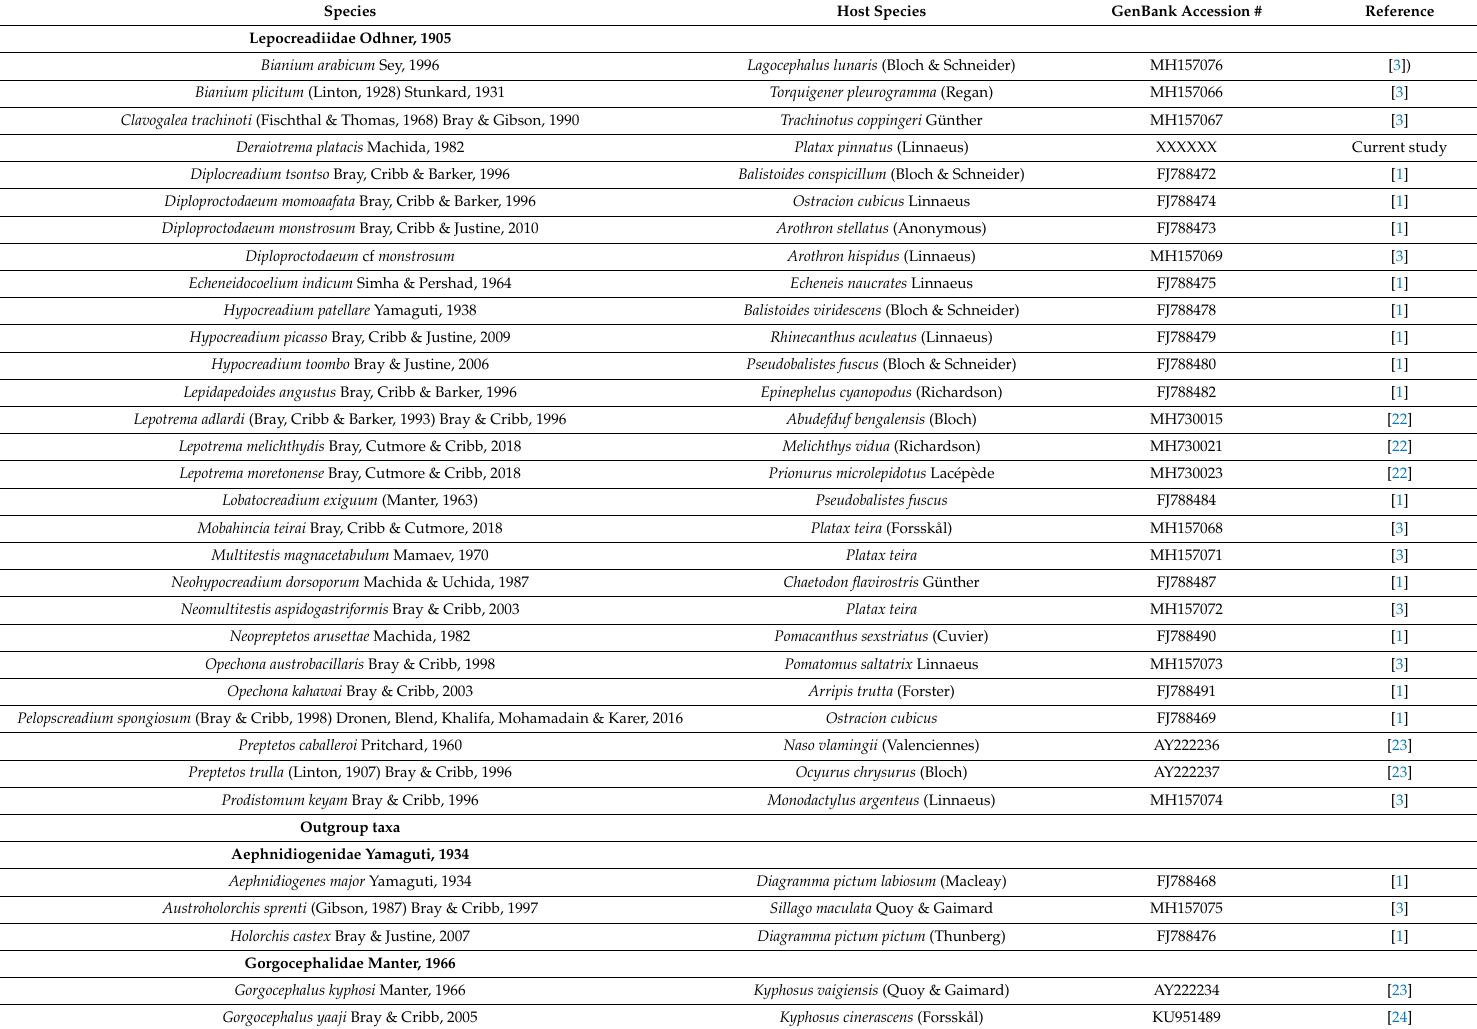
Table 1. Collection data and GenBank accession numbers for lepocreadioid species analysed in this study.